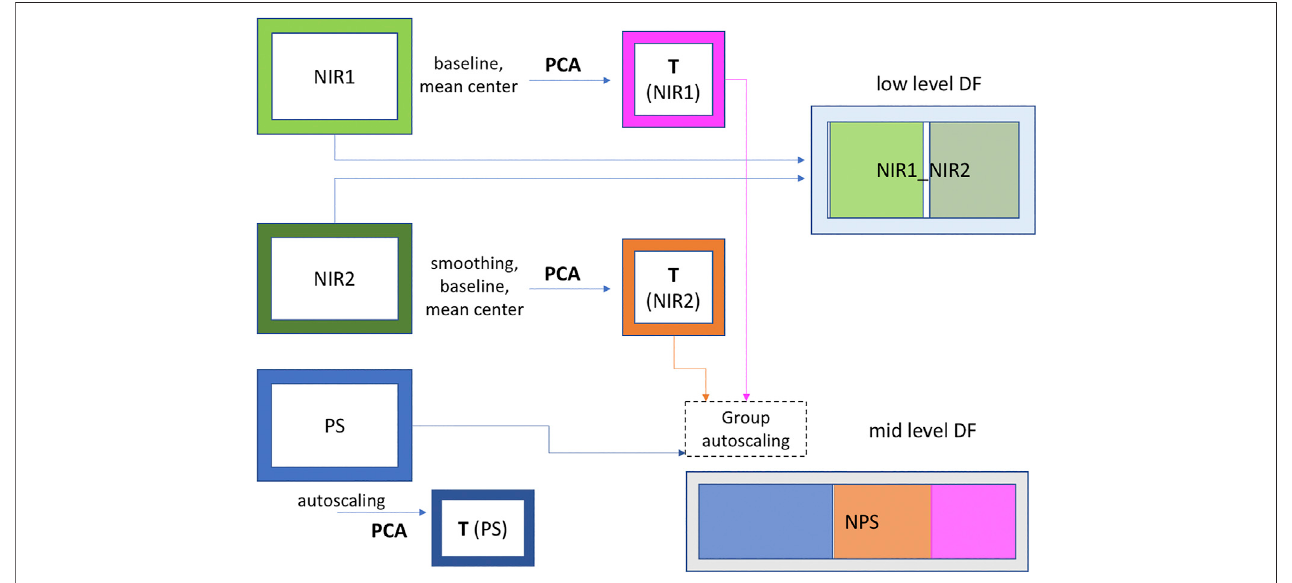
FIGURE 2 | Schematic representation of data sets